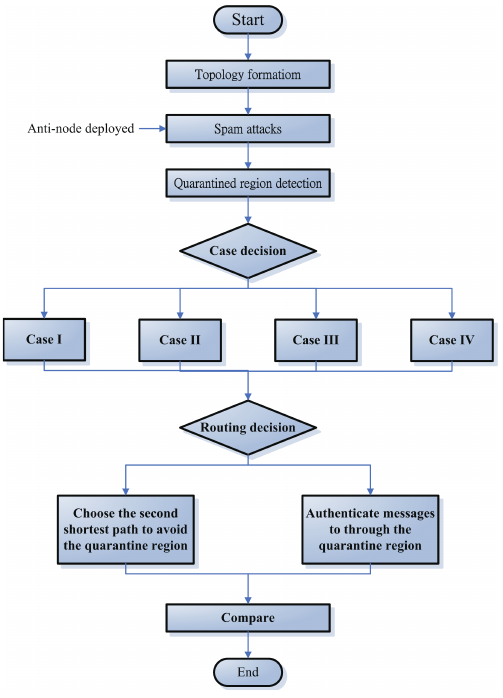
Figure 11. The simulation flowchart of the SADTCA scheme.